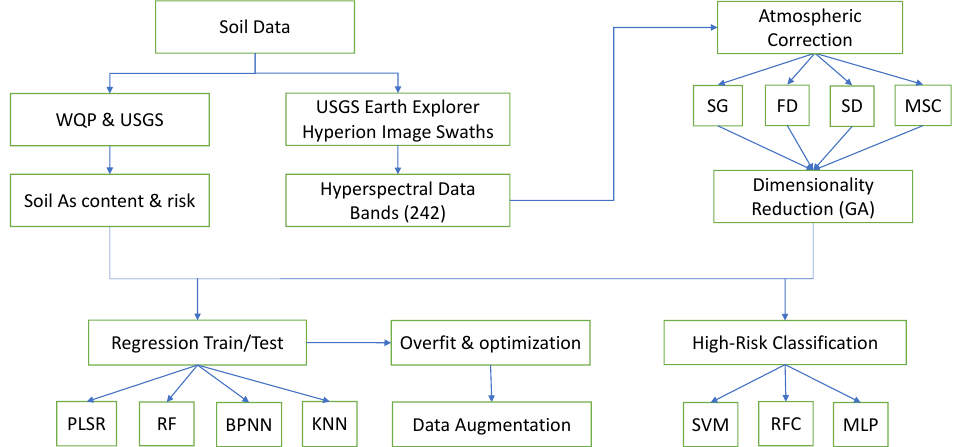
Figure 1. Workflow diagram for arsenic detection from hyperspectral satellite data. WQP stands for the Water Quality Portal and USGS is the United States Geological Survey. Other abbreviations are listed at end of the